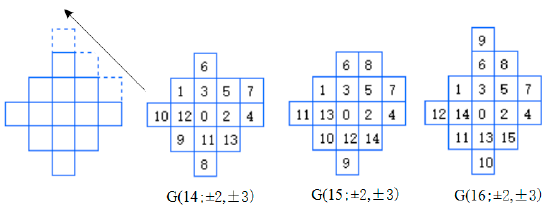
Figure 7. Adding vertices to G d .